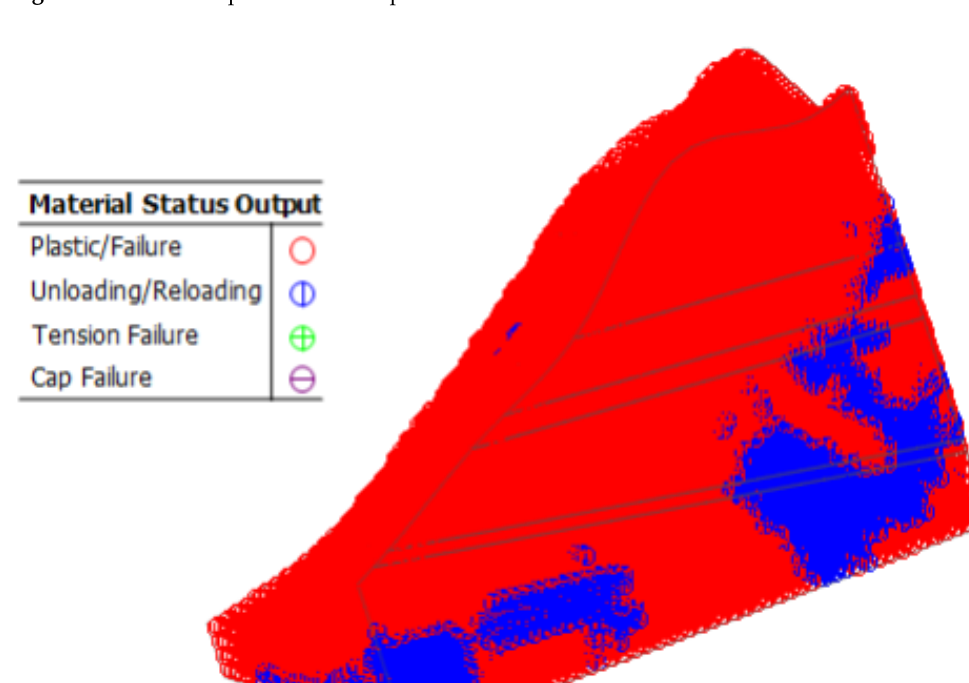
Figure 22. Overall displacement of slope.